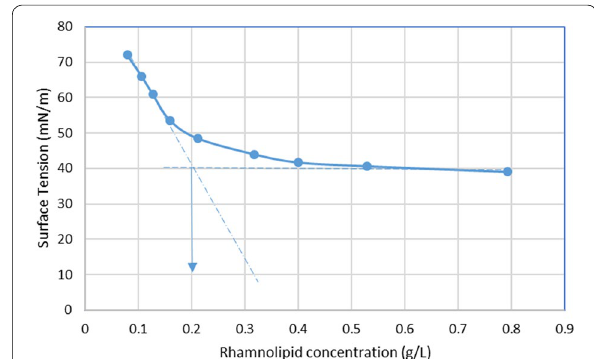
Fig. 4 A plot of surface tension as a function of concentration of aqueous RL solution